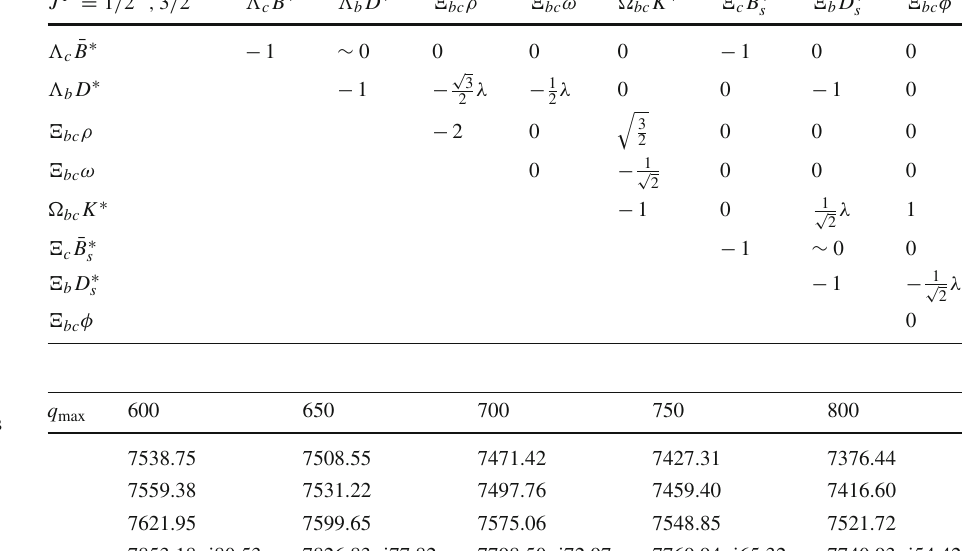
Table 23 D ij coefficients for sector J P = 1 / 2 − , 3 / 2 − (MA)